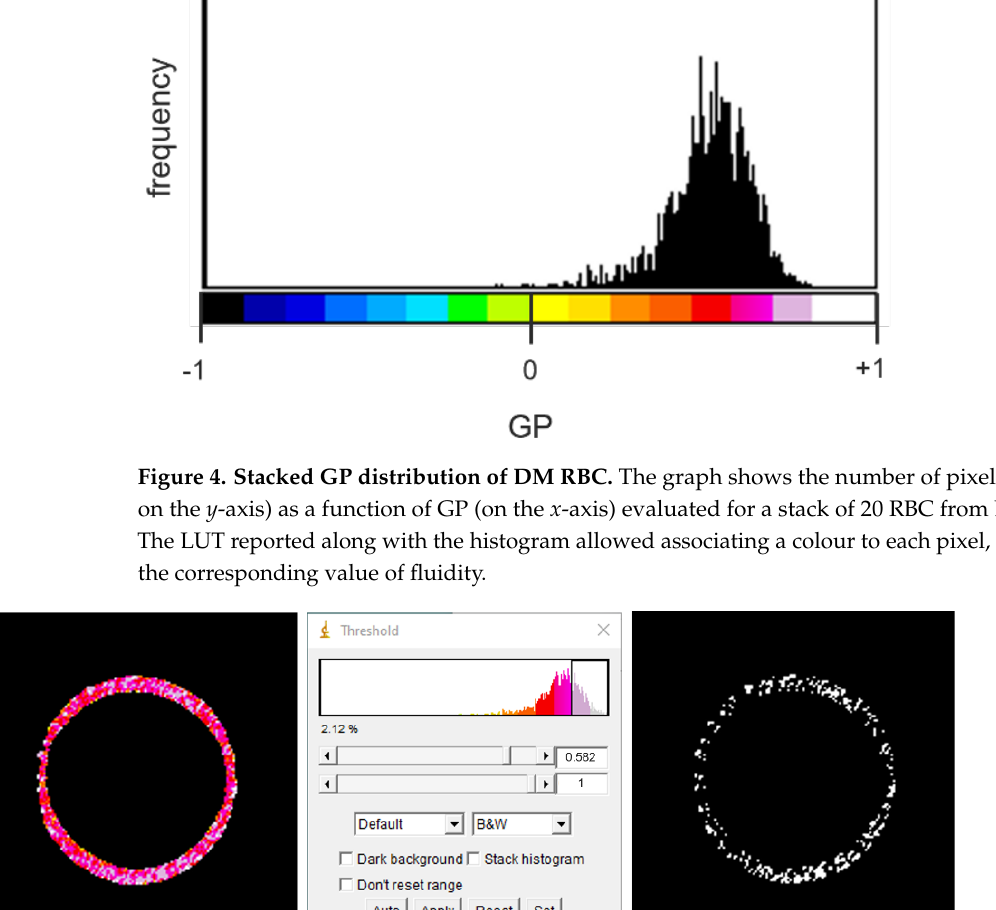
Figure 5. Construction of the binary mask representing LC domains in RBC membrane. Setting a proper threshold, corresponding in our case to values of GP belonging to the highest quartile (histogram, in the centre), allowed isolating domains from the GP map (represented in a color-coded scale on the left) and obtaining a binary mask of LC domains for each RBC (on the right).